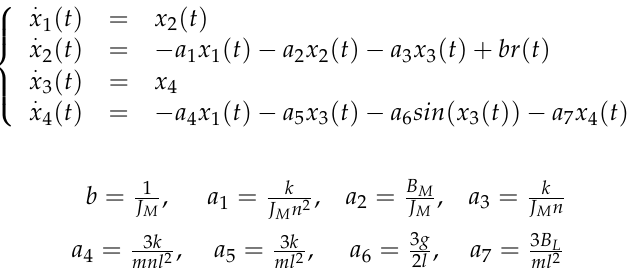
From a block diagram of the motorized hybrid soft leg (see Figure 3), it is easily pointed out that this hybrid soft leg is NLTV since the sine function in the feedback loop of the system causes nonlinearity in the system, and the state variable x is dependent on function of time t, which yields some problems in designing an effective controller. The nonlinearity should be examined for designing a proper controller and analyzing stability of the system. In this study, we apply dynamic Routh’s stability criterion [51] to analyze the stability of this nonlinear hybrid soft leg system. Dynamic Routh’s stability criterion has advantages to analyze NLTV systems due to its simplicity as Routh’s stability criterion Figure 3. Block diagram of the hybrid soft leg with rigid links and a flexible joint (spring). The sys- for linear time-invariant (LTI) systems. tem has both linear and nonlinear feedback.